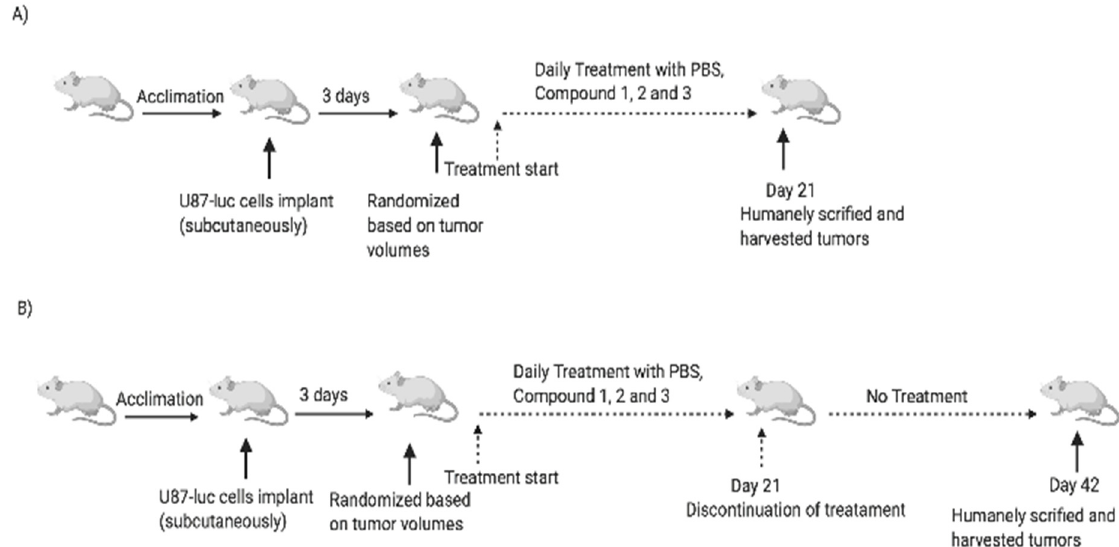
Figure 2. Protocol for subcutaneous administration of compounds in mice with U87-luc xenografts. ( A ) ON Treatment: the compounds were administered daily, s.c. for 21 days, and ( B ) ON + OFF Treatment: the compounds were administrated daily for 21 days followed by 21 days of discontinuation. At the end of the study, the animals were humanely sacrificed, and the tumors were harvested.